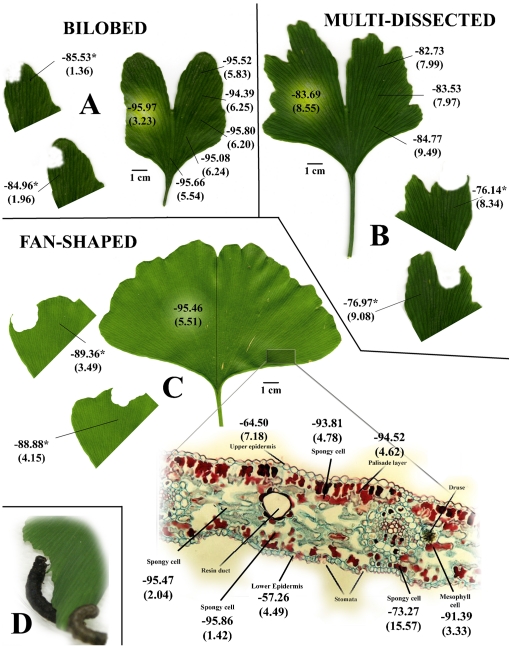

G. biloba is characterized by different leaf types, depending on the age and shape of the leaf.
A, bilobed; B, multi-dissected and; C, fan-shaped. Vm values are reported along with standard errors (in brackets) as mV (n≈50). Herbivore wounding is shown in leaf segments and Vm values are indicated below and aside the wounding zone. The leaf section of C shows Vm values of the different mesophyll and epidermal cells of a fan-shaped leaf. D, Spodoptera littoralis feeding on G. biloba leaves.